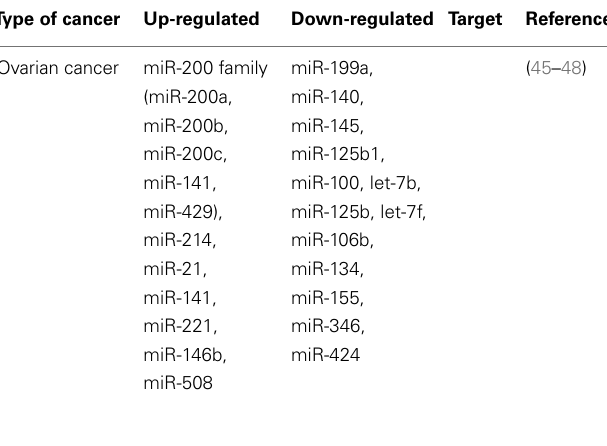
Table 1 |Alterations in multiple miRNAs among ovarian